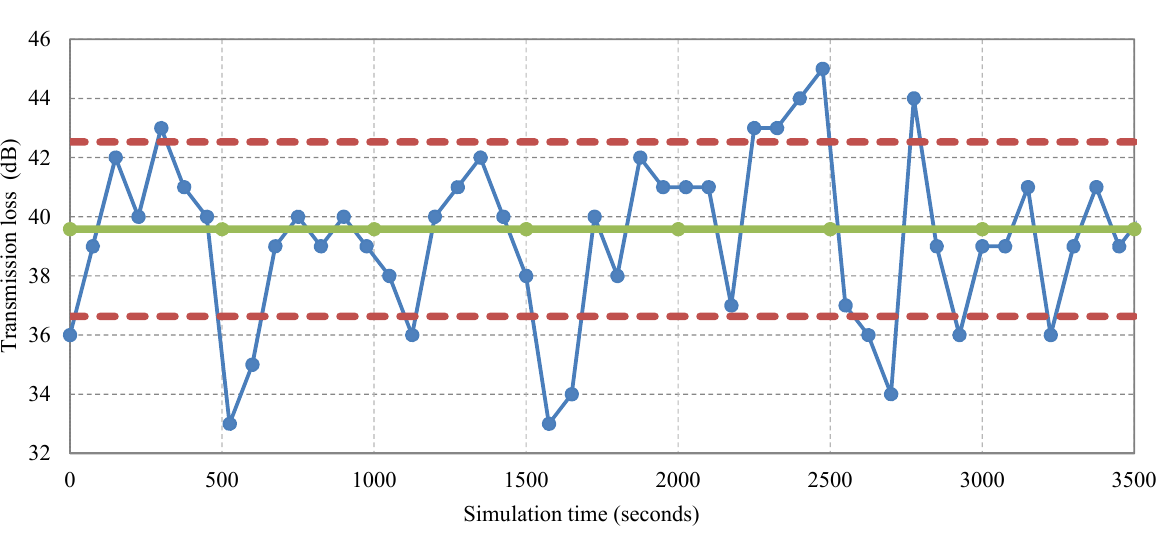
Figure 1. An ensemble of transmission losses calculated by the Bellhop model. Solid line indicates the average calculated over the total run time. Dashed lines indicate the values of one standard deviation σ